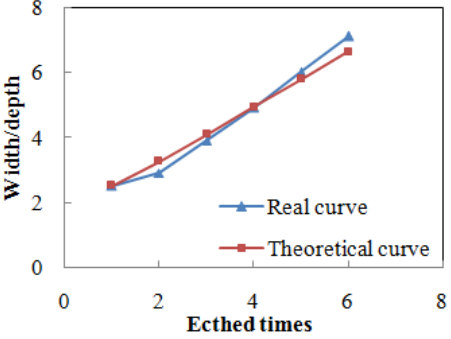
Figure 5. Transformation process of HF etching.